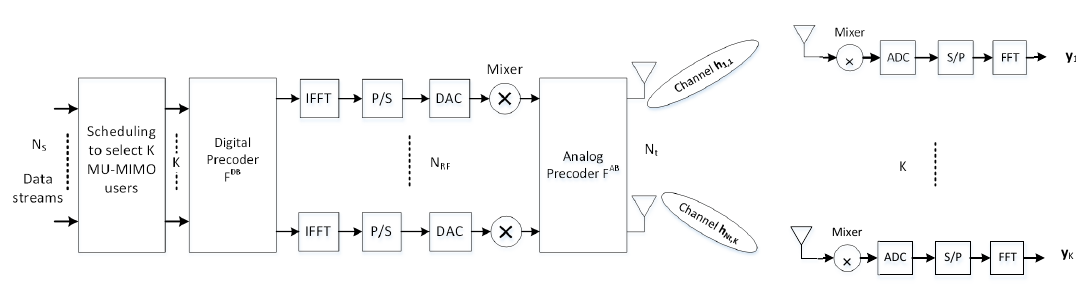
Figure 3. Block diagram of mmWave massive MIMO BS and